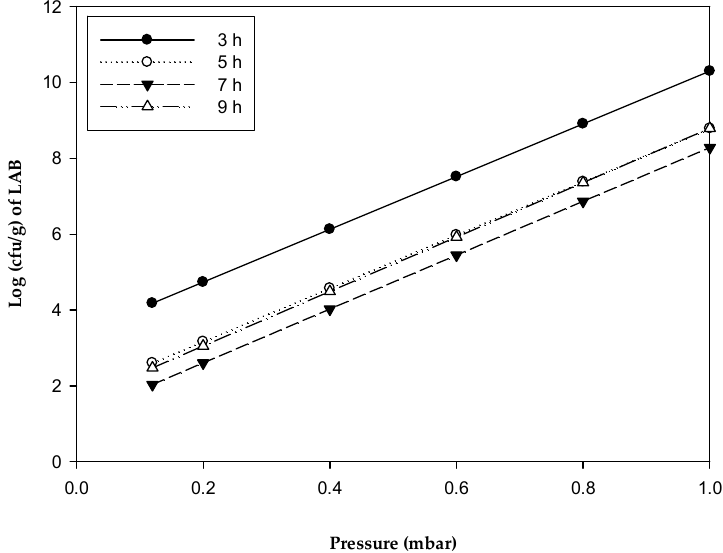
Figure 5. Predicted log (cfu/g) of LAB of dried MKG at different freezing times and pressures. 255